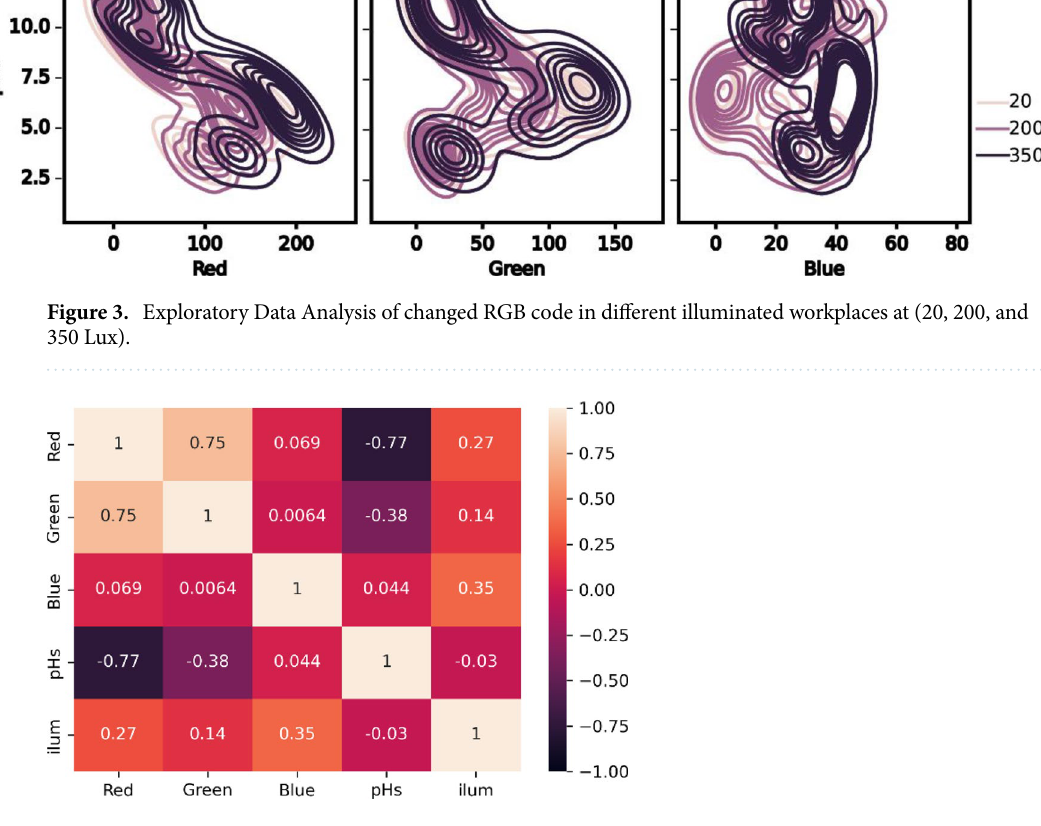
Figure 4. Pearson’s correlation coefficients between the pH